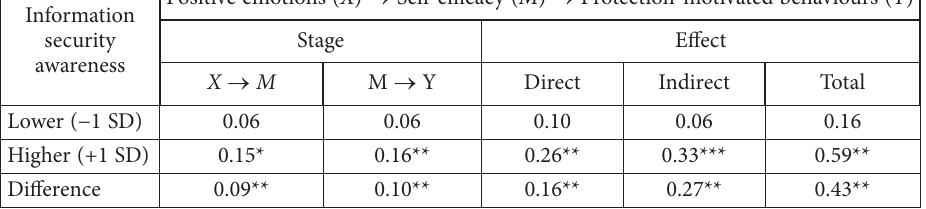
Table 6. Mediating effect under different levels of information security awareness Information